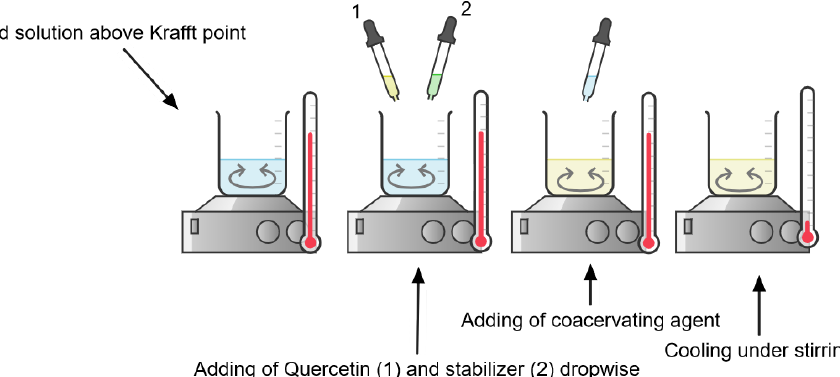
Figure 2. Steps of coacervation process for QuercSLN (Created with Chemix).